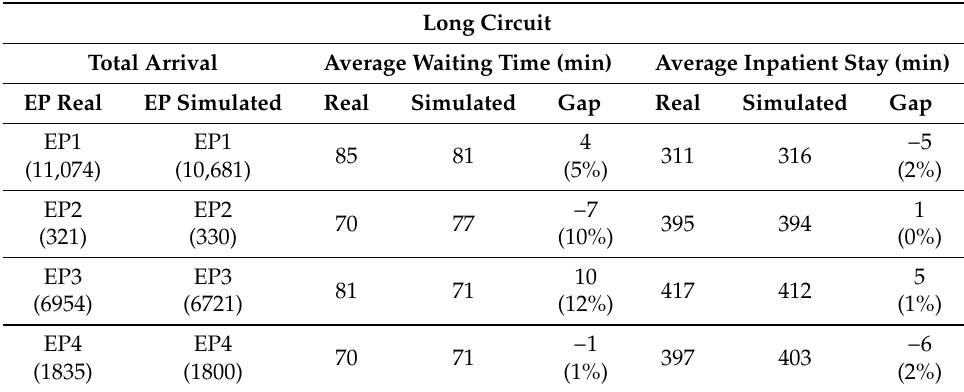
Table 3. Comparison of performance based on EP category—long